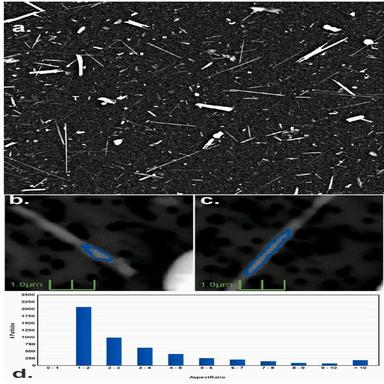
(A) Example of backscattered electron micrograph from automated SEM analysis of amphibole reference material. (B) and (C) examples of incorrectly segmented fiber features showing that regions measured (outlined in blue) do not match areas of the image that are clearly portions of fiber that have not been measured. (D) histogram of aspect ratios measured from (A) showing by observation that the distribution is skewed to lower aspect ratios. (For interpretation of the references to color in this figure legend